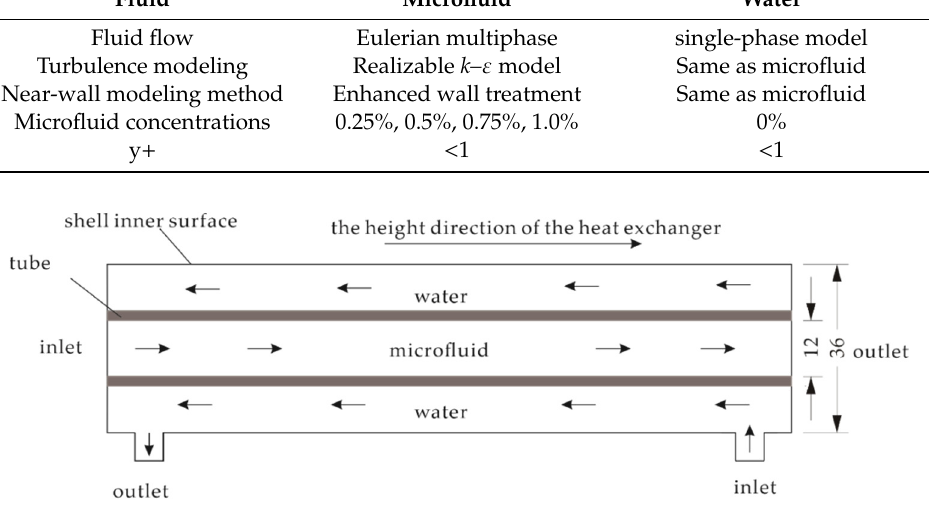
Table 5. Details of the computational conditions.